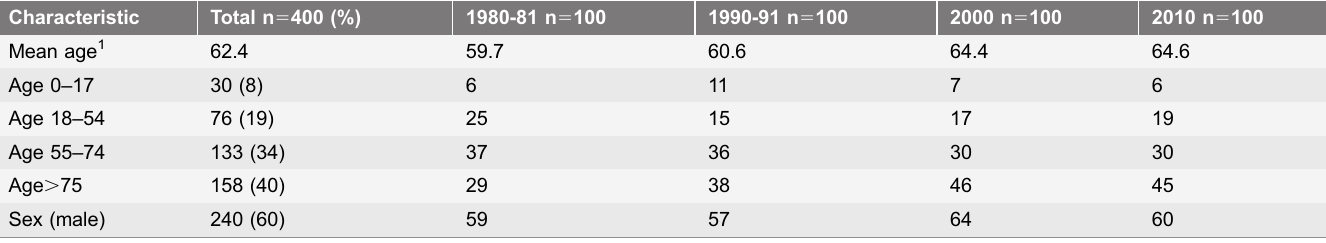
Table 1. Characteristics of patients with blood cultures positive for S. aureus